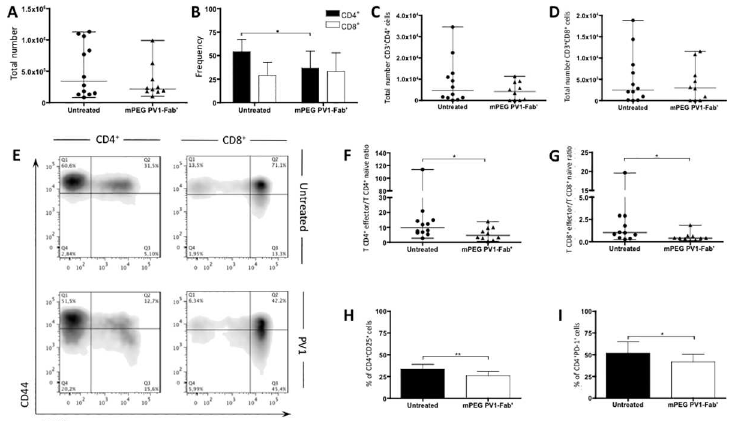
Fig 2. PV1-treated mice exhibited less activated eye-infiltrating lymphocytes. B10.RIII mice were immunized with 50 μ g/animalof 161–180IRBP in CFA, plus 500 ng/animal of PTx boost. Starting on day 9, mice were treated every 4 days with CD28 antagonist, PV1 (10mg/Kg; ip), or left untreated. On day 14 mice were sacrificedand eyes were collectedfor immunophenotypingof eye-infiltrating leukocytes. (A) Total count of eye-infiltrating leukocytes. (B) Frequency of CD4 + and CD8 + T lymphocytes infiltratingthe eyes of B10.RIII mice. (C) Total number of CD4 + T lymphocytes and (D) CD8 + T lymphocytes. (E) Representative plots display CD44 and CD62L expressionby CD4 + and CD8 + cells. (F) T effector /T na ï ve ratio (as definedby CD44 and CD62Lexpression) for CD4 + and (G) CD8 + T lymphocytes. (H) Frequency of CD4 + CD25 + T cells in uveitic eyes. (I) Frequency of CD4 + PD-1 + T cells uveitic eyes. Data combinedfrom three independentexperiments; 5–10 mice per group. In (A), (C), (D), (F) and (G), medianand range are depicted. In (B), (H) and (I) Mean ± SD are depicted. * ,p < 0.05,two-tailed Mann-Whitney